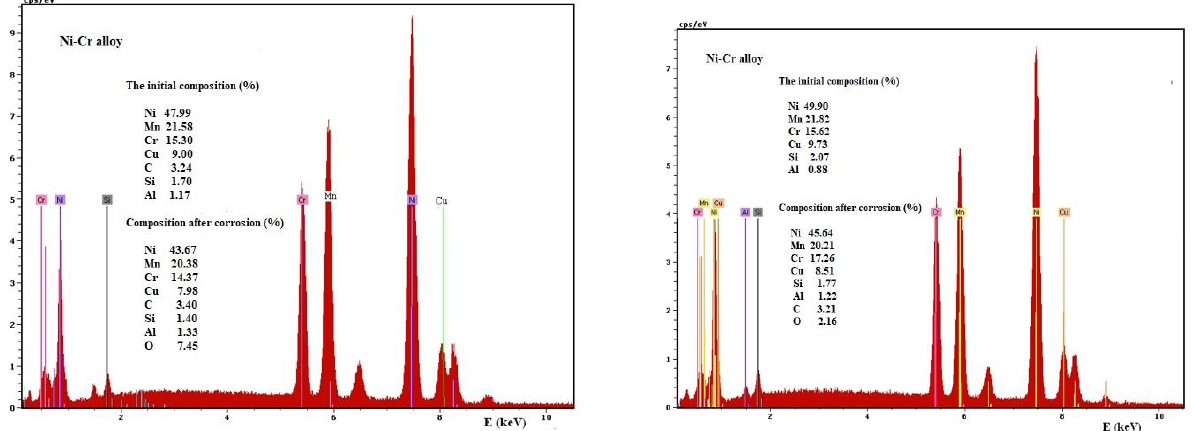
Figure 10. EDX spectrum of the Ni-Cr sample before corrosion and surface compositions, initially and after corrosion for two samples Ni-Cr alloy.